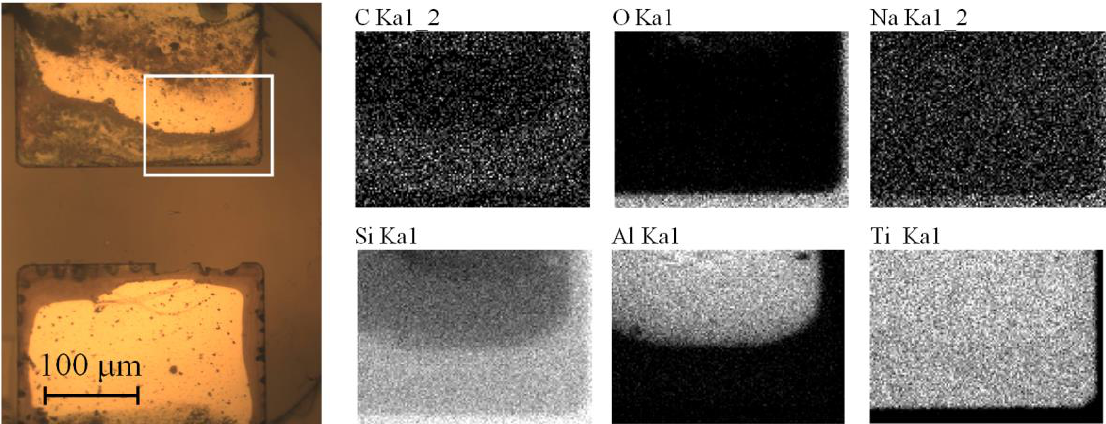
Figure 7. The electrodes after the test. The bottom electrode was grounded, while the AP voltage pulses with U a = 10 V were applied to the upper electrode during 60 s. The optical micrograph of the electrodes is shown on the left. The white rectangle indicates the area of EDX analysis. Right images demonstrate the EDX mapping of chemical elements at 30 kV accelerating voltage.